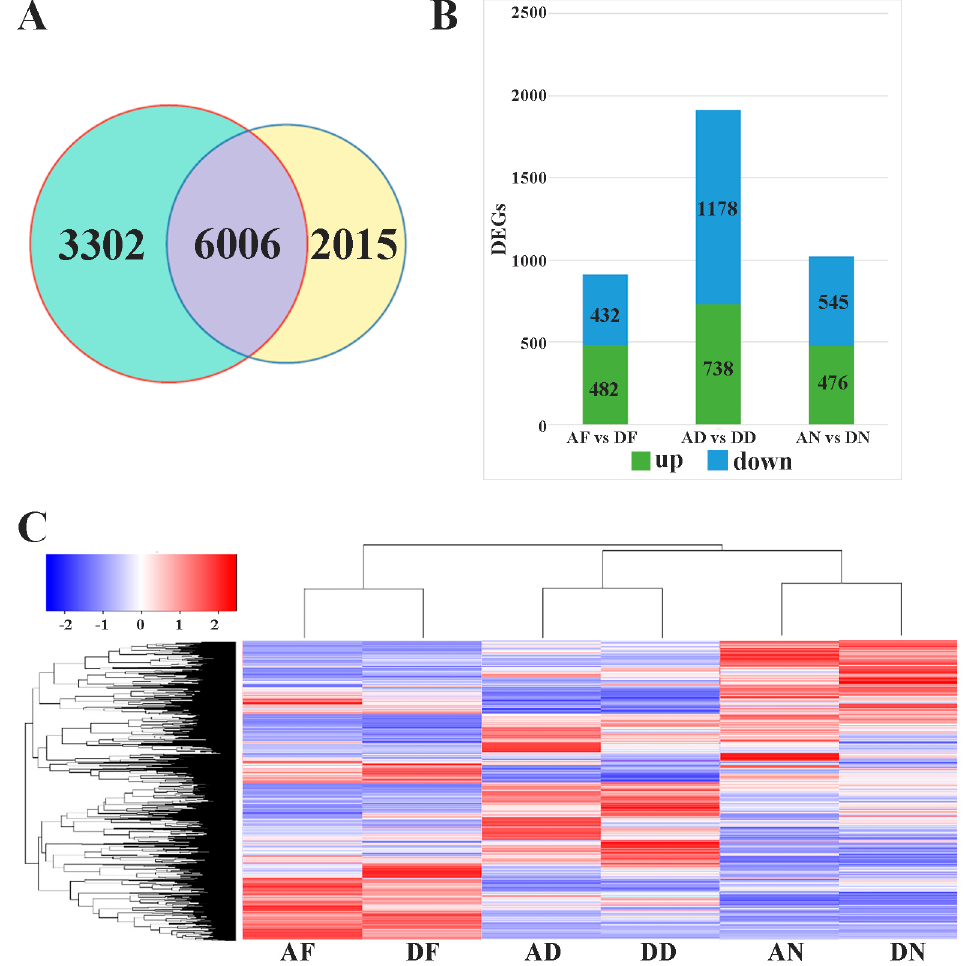
Figure 1. Comparative mRNA transcriptome between triploid and diploid poplar leaf during the day. ( A ) Venn diagram of the number of di ff erentially expressed genes in triploid (cyan) and diploid (yellow) seed germination. ( B ) The number of di ff erentially expressed genes in triploid and diploid leaf. Aquamarine color bars refer to downregulated genes; green color bars refer to upregulated genes. ( C ) Expression of the di ff erentially expressed genes identified in one day. The AF, AD, and AN abbreviations represent the triploids at 04:00, 09:00, and 21:00, respectively; DF, DD, and DN represent the diploids at 04:00, 09:00, and 21:00, respectively.